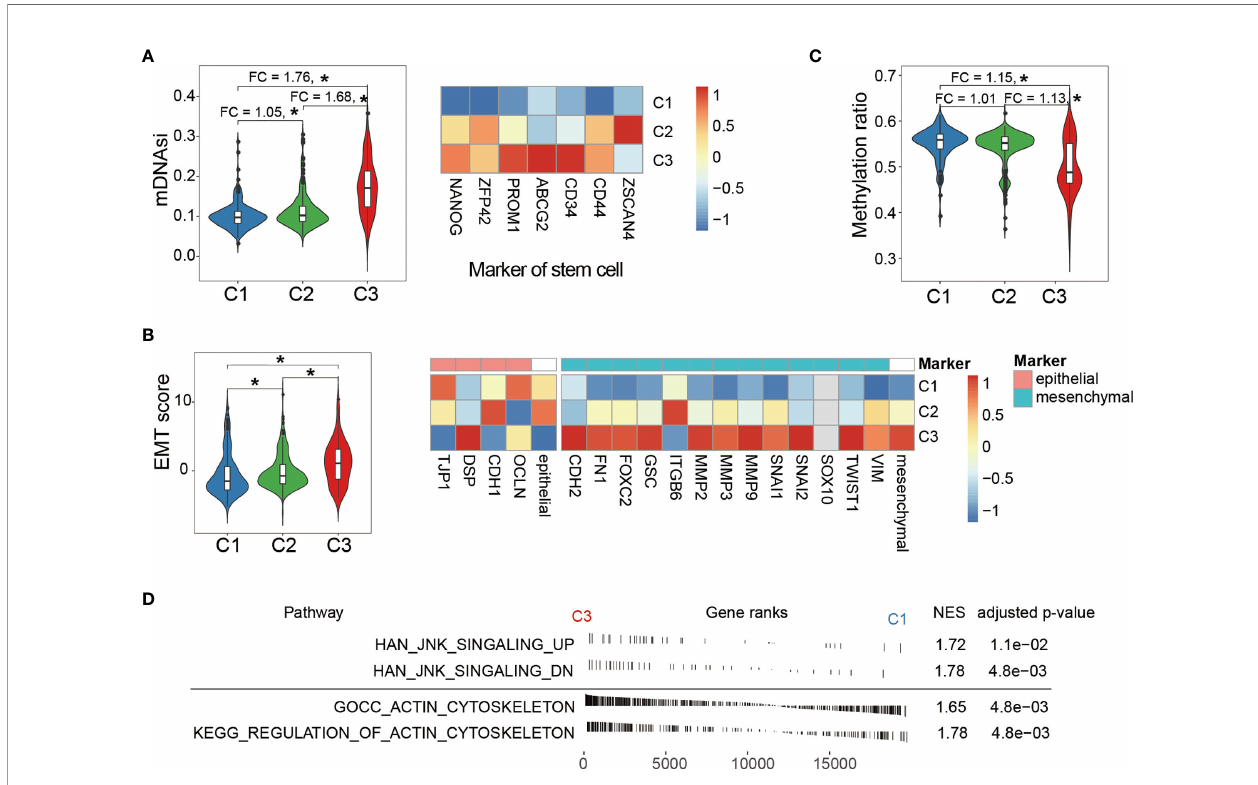
FIGURE 4 | Comparison of phenotypic characteristics between LGG subtypes. (A) C3 shows signi fi cantly higher mDNAsi (left panel), an index re fl ecting cell stemness. The fold change of mDNAsi between groups was labeled at the top. Comparison of expression of cell stemness marker genes between the LGG groups (right panel). (B) EMT score comparison between the LGG groups (left panel). Comparison of expression of EMT marker genes shows severe tendency toward mesenchymal transition in the C3 group (right panel). Expressions of marker genes were taken by average and are shown at the right side of the epithelial and mesenchymal panel. (C) Comparison of global methylation levels indicated that C3 displayed extended de-differentiation. Fold changes between the LGG groups were labeled at the top. (D) Enrichment analysis showed that LGG samples in C3 exhibited elevated activity in both cytoskeleton and JNK signaling. NES indicates normalized enrichment score. *P <